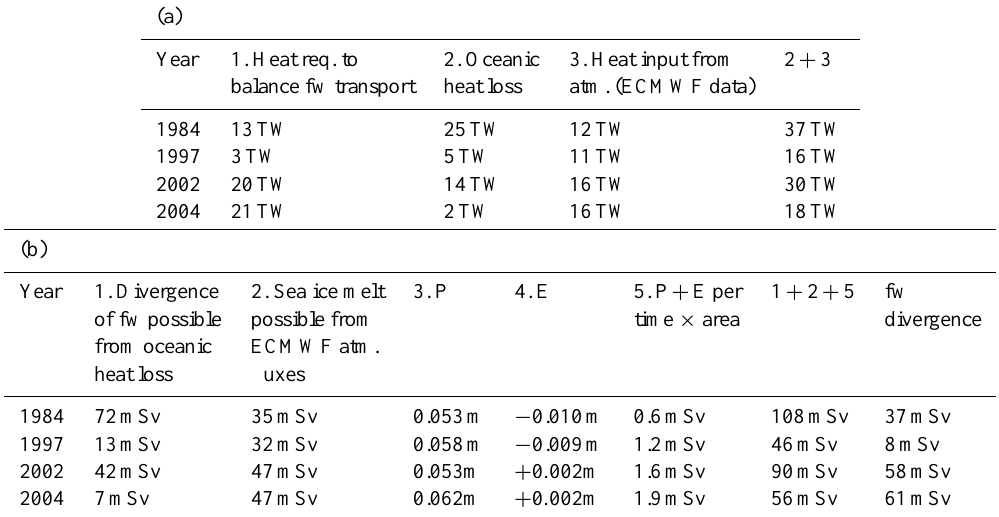
Table 6. Heat and freshwater (fw) convergence/divergence from hydrographic and ERA Interim data, with the varying averages as reference temperature and salinity. (a) Heat lost by the ocean (column 2) and heat input from the atmosphere between the two zonal sections (column 3) as compared with the heat required to balance the freshwater transport via ice melt (column 1). (b) Freshwater divergence from the hydrographic data (last column) as compared with the divergence of freshwater possible from the oceanic heat loss (column 1), sea ice melt possible from the ERA Interim atmospheric data (2) and precipitation and evaporation (downward fluxes positive) (column 5) from the ERA Interim data. Precipitation (P) and evaporation (E) from the ERA Interim data are computed for an area with ice concentration less than